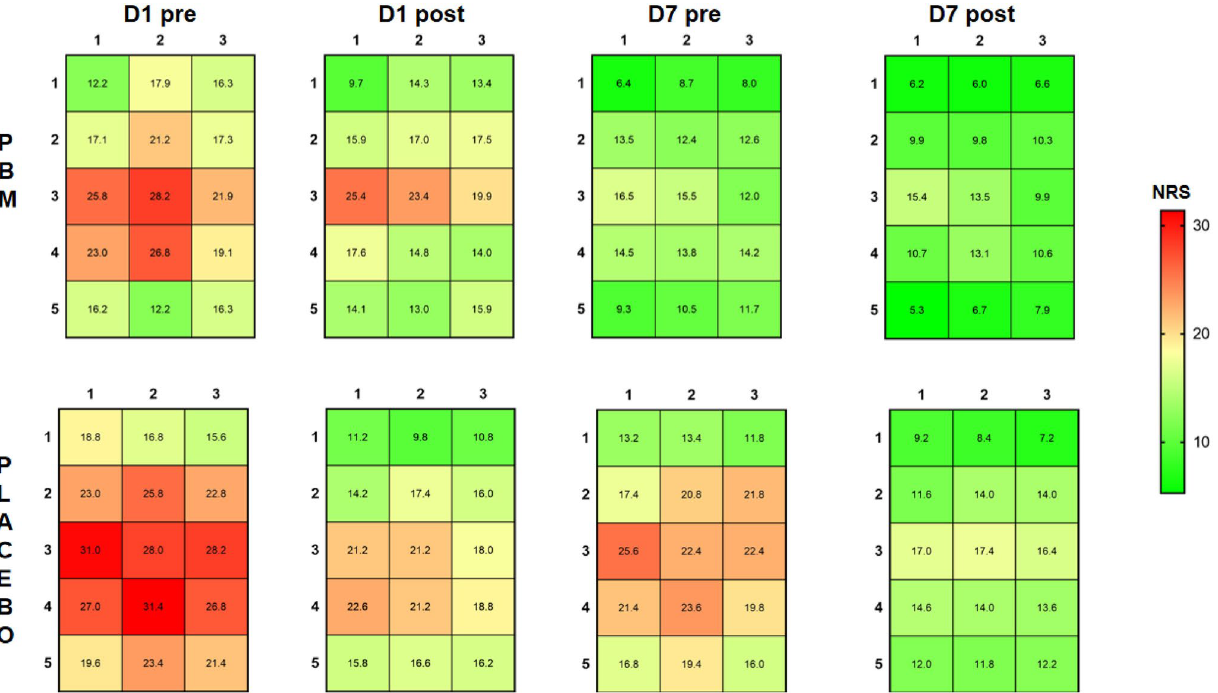
Figure 3. The mechanical sensitivity mapping of masseter myalgia patients before and after the treatment with photobiomodulation (PBM) (n = 25) and placebo (n = 25). NRS: numerical rating scale from 0–50–100 with 50 = moderate painful. Measurements were taken before and after treatment at Day 1 and Day 7 (D1 pre/D1 post; D7 pre/D7 post).